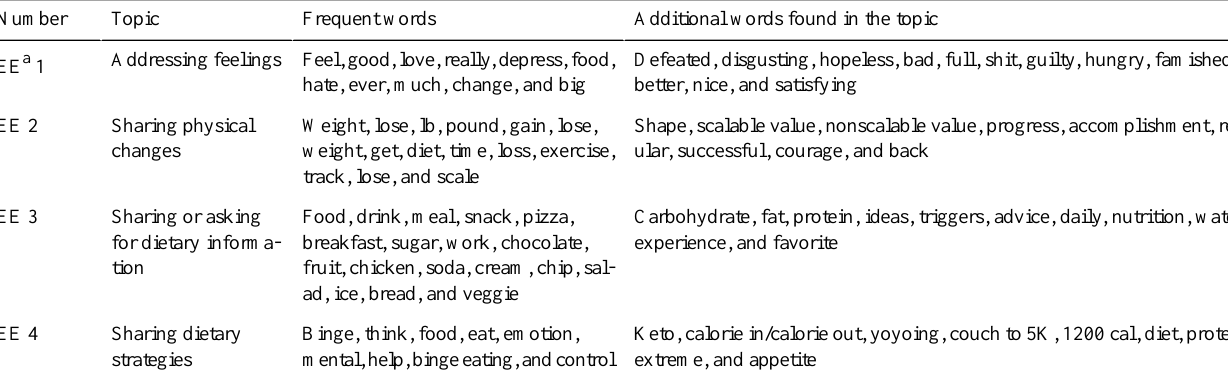
Table 3. Topics of emotional eating behavior and distinguishable linguistic differences.